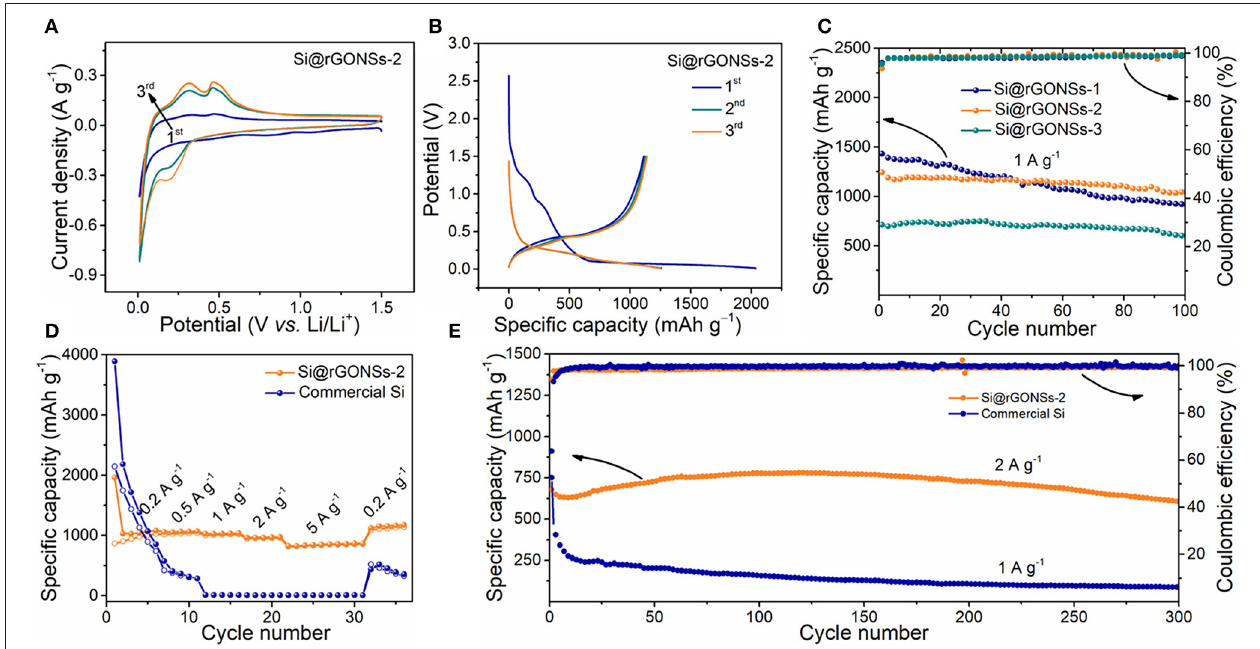
FIGURE 3 | Electrochemical performances of Si@rGONS composites. (A) CV curves at a scan rate of 0.1mV s − 1 of Si@rGONSs-2, (B) first three galvanostatic discharge–charge curves at 200mA g − 1 of Si@rGONSs-2, (C) cycling curves of Si@rGONS composites at 1A g − 1 , (D) rate curves of Si@rGONSs-2 and commercial Si, and (E) cycling curves of Si@rGONSs-2 at 2A g − 1 and commercial Si at 1A g − 1